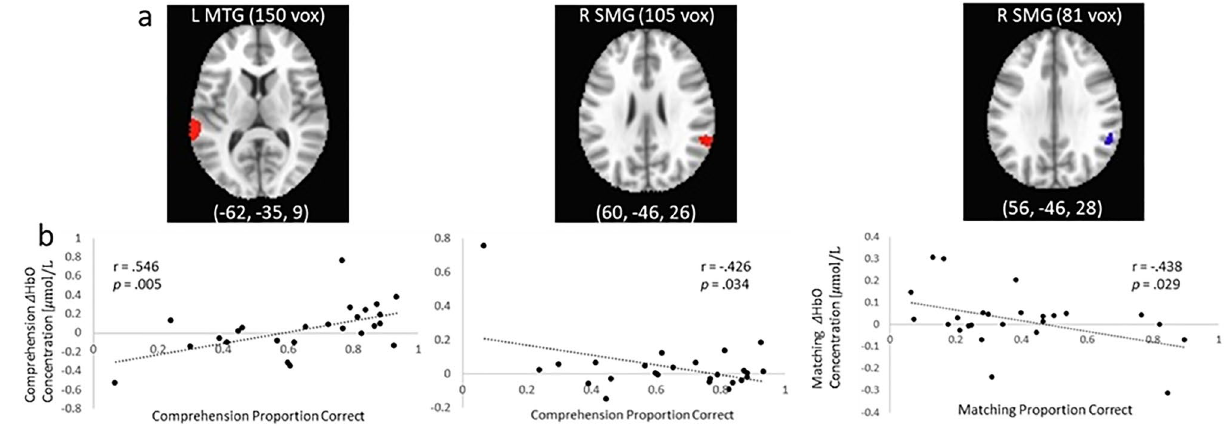
Figure 4. Comprehension and matching activation and performance at 33 months were associated. ( a ) Location of clusters displaying activation in L MTG (middle temporal gyrus) and R SMG (supramarginal gyrus) ( b ) Comprehension and matching performance were associated with task